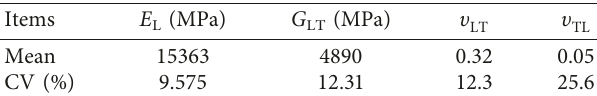
Table 1: Mechanical properties of PSB composites in parallel-to- grain direction.